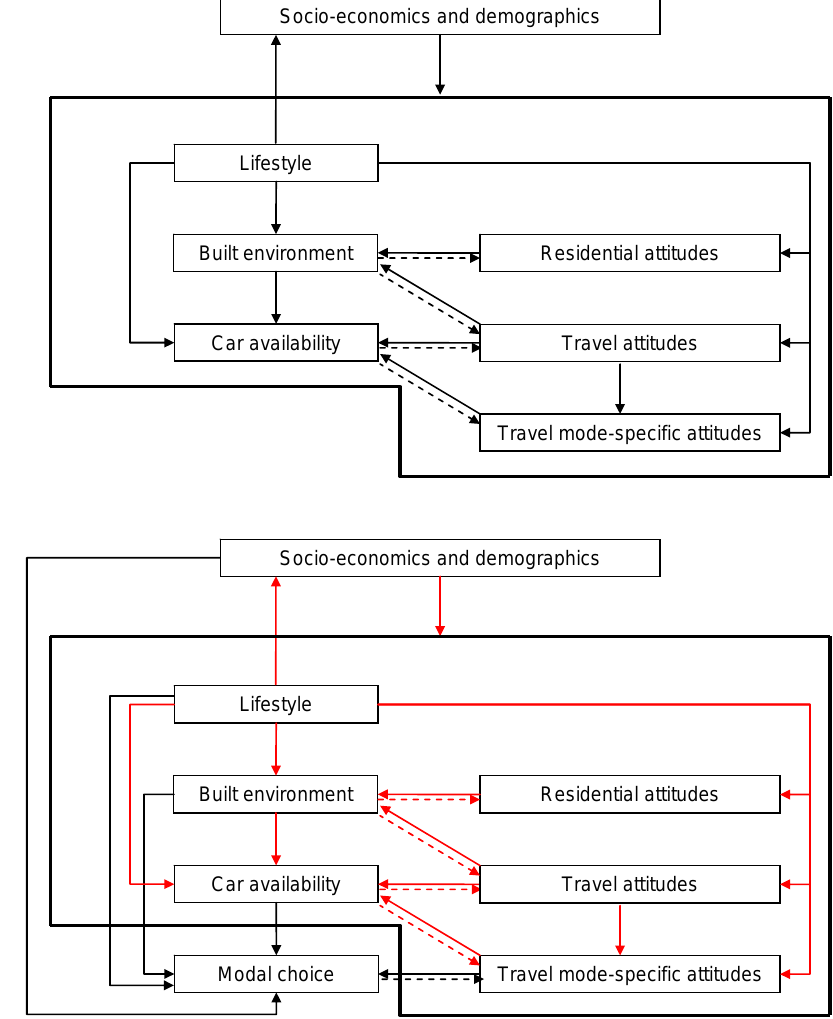
Figure 3. Two-step estimation